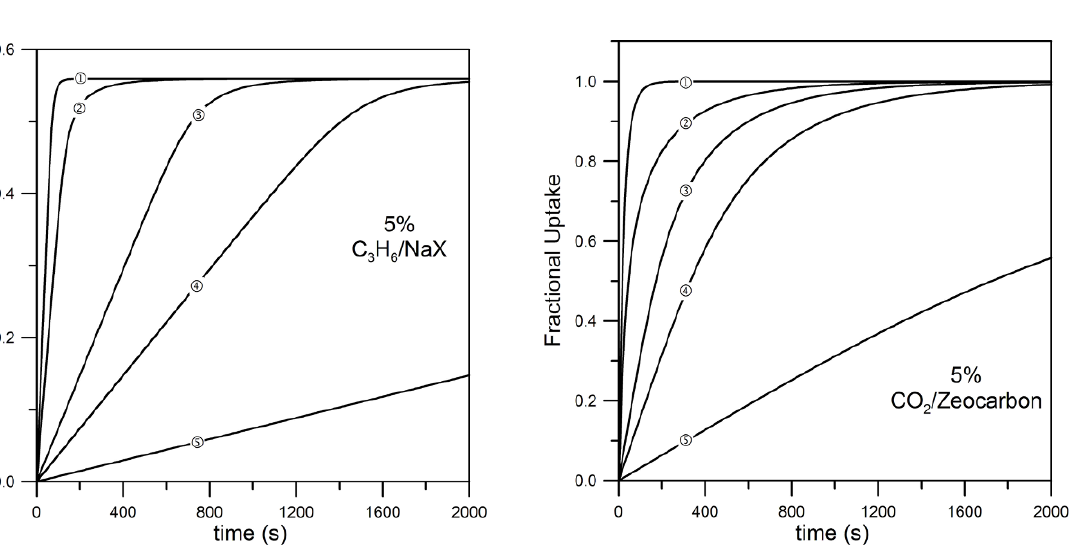
Figure 9. Theoretical kinetic isotherms of CO H adsorbed on 3 6 zeocarbon at 273 K calculated using Eq. 10 and the values of parameters collected in Tables 3 and 4. The bulk phase concentration is equal to 5% and the total bulk gas pressure is 101.325 kPa. The corresponding equilibrium adsorption data were reported by Seok and Kim [21].